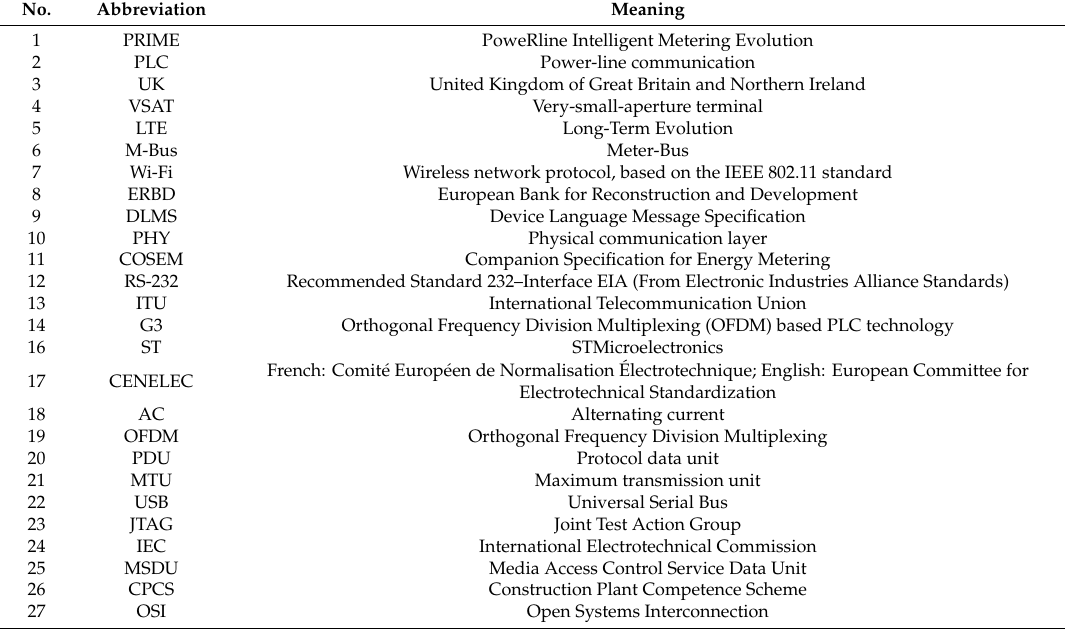
Table 1. Notations and